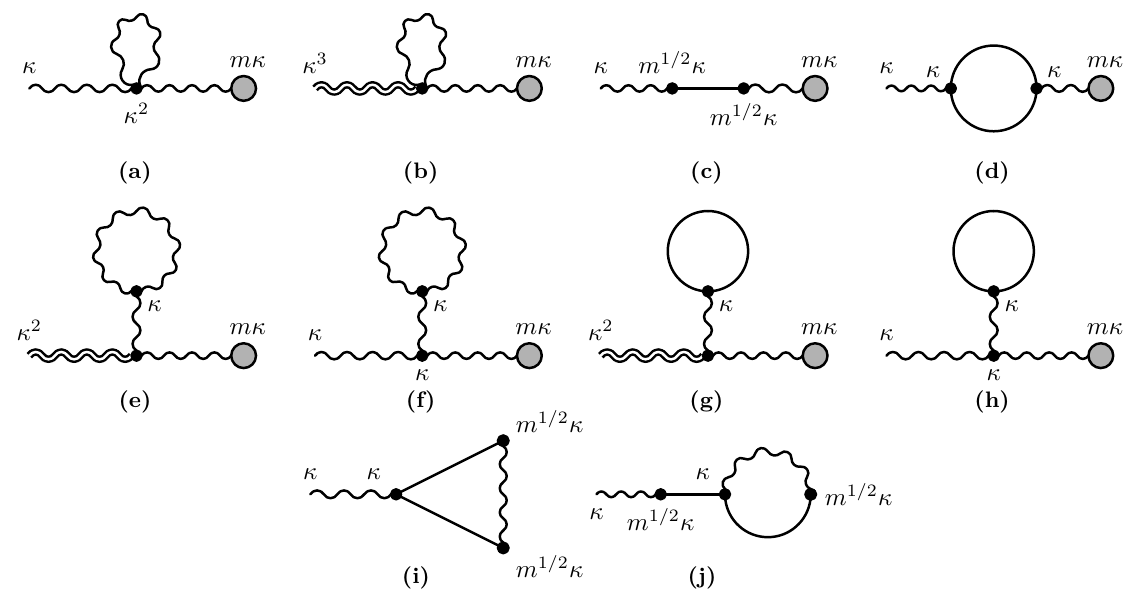
Figure 5. These contributions vanish due to a massless closed graviton loop (a, b, e, f), closed- y loops (g, h), and graviton propagators that propagate from the worldline to the worldline (c, d). In addition, the diagrams i and j result in scaleless integrals and vanish as